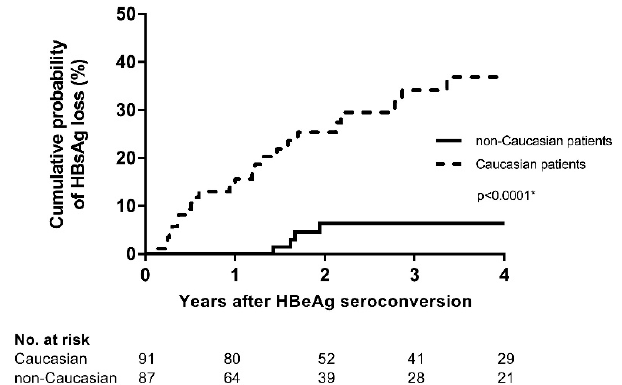
Figure 2. Kaplan – Meier curve showing the difference in HBsAg loss rates between patients of Caucasian and non-Caucasian ethnicity irrespective of treatment status after HBeAg seroconversion. * p -value = log-rank. HBsAg: Hepatitis B surface Antigen, HBeAg: Hepatitis B e Antigen.